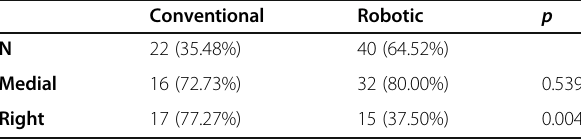
Table 1 The comparison between conventional and robotic- assisted UKA is summarized. No difference was found in the proportion of medial UKA, but a higher percentage of right knee underwent conventional UKA Conventional Robotic